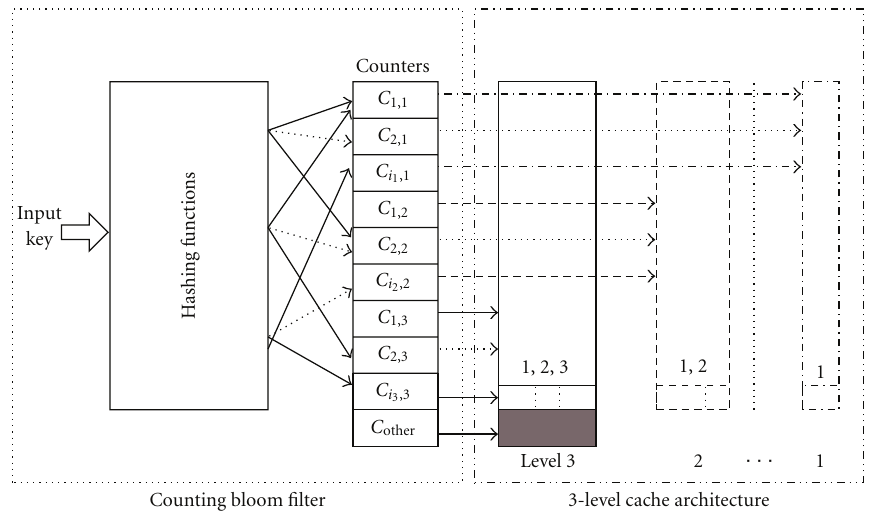
Figure 5: The 3-level cached counting Bloom filter